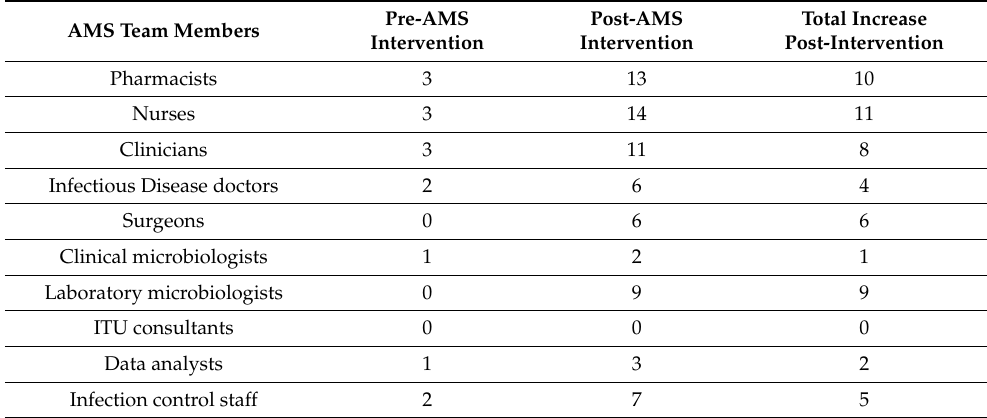
Table 2. Number of members by profession of multidisciplinary AMS teams, pre- and post-AMS intervention at CwPAMS project